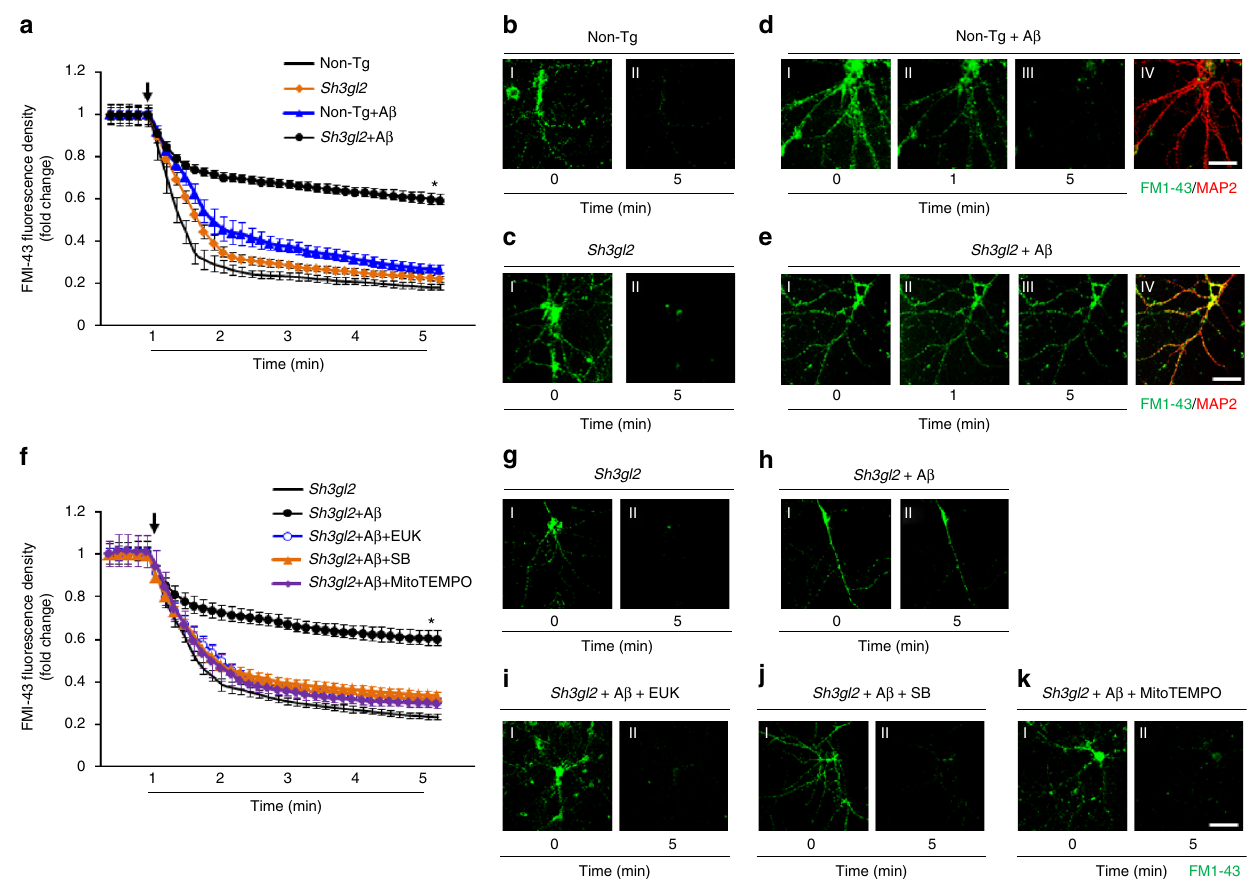
Fig. 9 Blocking EP-mediated oxidative stress and p38 activation rescued A β -induced synaptic vesicle recycling impairment. Fourteen-day in vitro cultured cortical neurons, either non-Tg or Tg Sh3gl2 , were treated with 50 nM A β for 24 h, with or without 500 nM EUK-134, 1 μ M SB203580/SB, or 1 μ M MitoTEMPO pretreatment for 1 h before the addition of A β . To visualize synaptic vesicle recycling, the cells were loaded with the fl uorescent styryl dye FM1 – 43 before and after stimulation with 50 mM K + for the indicated time. a , f Kinetics of FM1 – 43 unloading of synaptic boutons during sustained stimulation with 50 mM KCl. b – e Fluorescence images before (I) and after (II, III) FM1 – 43 unloading with 50 mM KCl, and the representative immuno fl uorescence images of MAP2 (red, IV) to ensure the position of FM1 – 43 fl uorescence (green, IV in d , e ). Tg Sh3gl2 neurons treated with 50 nM A β for 24 h alone ( e , h ) showed synaptic vesicle release impairment compared to the vehicle Tg Sh3gl2 treatment ( c , g ) and non-Tg neurons, whereas treatment with 50 nM A β ( d ) showed no difference compared to the vehicle non-Tg neurons ( b ). Pretreatment with 500 nM EUK-134 ( i ), 1 μ M SB203580 ( j ), or 1 μ M MitoTEMPO ( k ) rescued A β -induced synaptic vesicle recycling impairment in Tg Sh3gl2 neurons. Scale bar = 50 µ m. Error bars represent s.e. m., n = 8 per group. * p < 0.01 compared to other groups in a and f (one-way